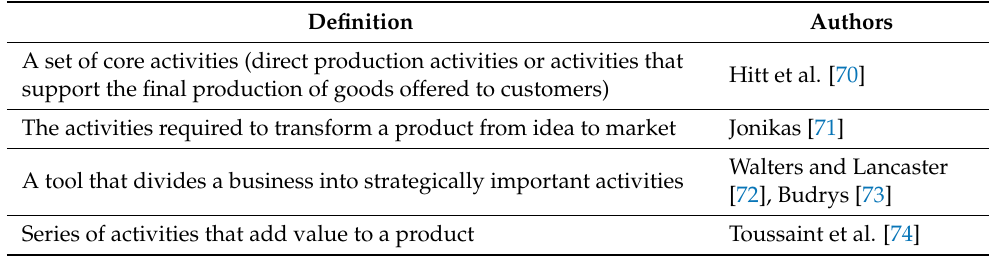
Table 6. Diversity of value chain